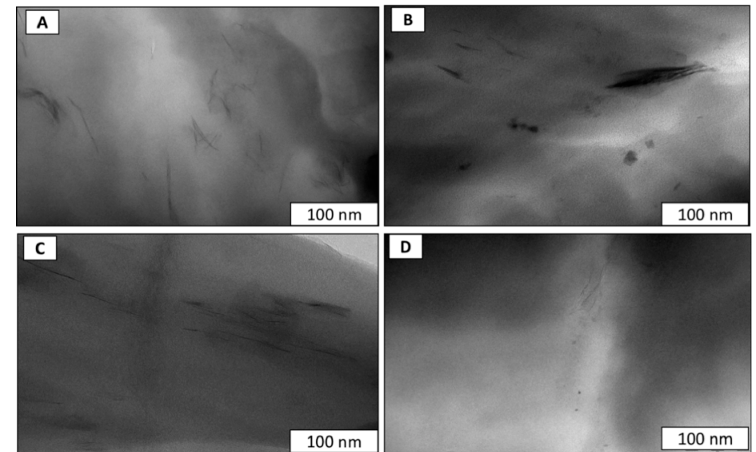
Figure 2. TEM micrographs of ( A ) LLDPE.Fu15.MMT5 film, ( B ) LLDPE.Fu15.MMT-Fe6.25 film, ( C ) LLDPE.Fu15.MMT3 film, and ( D ) LLDPE.Fu15.MMT-Fe3.75 film.